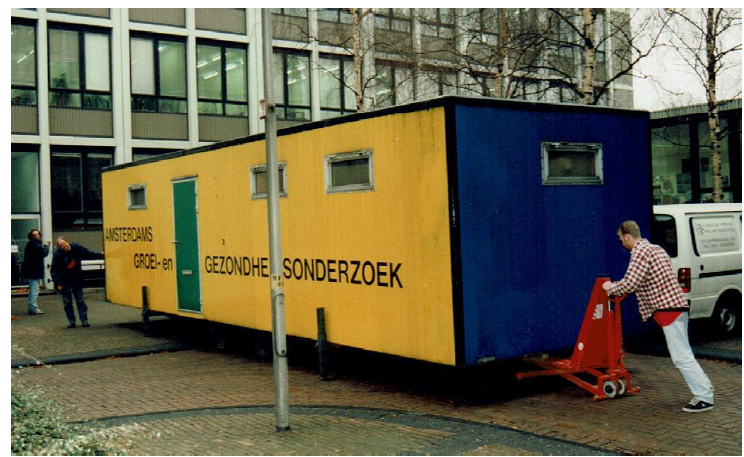
Figure 4. The mobile laboratory ready for transport to one of the two secondary schools.